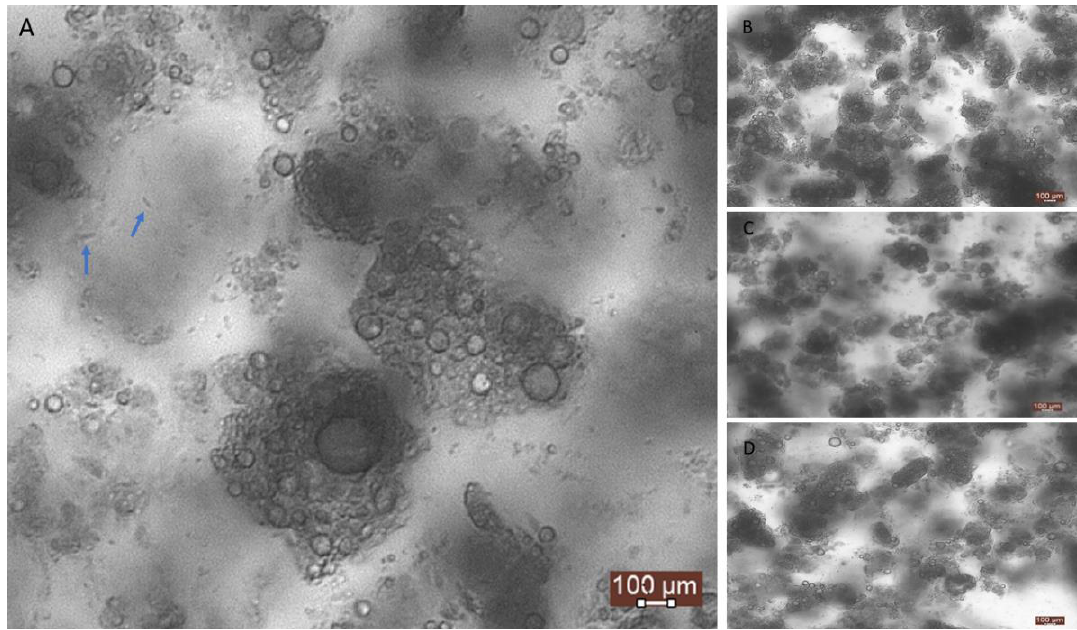
Figure 3. Optical microscopy images of yogurt-based beverages after 28 days of storage. ( A ) Control, ( B ) Control pasteurised, ( C ) Tocopherol and ( D ) Tocopherol-pasteurised. Arrows indicate the presence of lactic acid bacteria. Scale bar represents 100 μm.